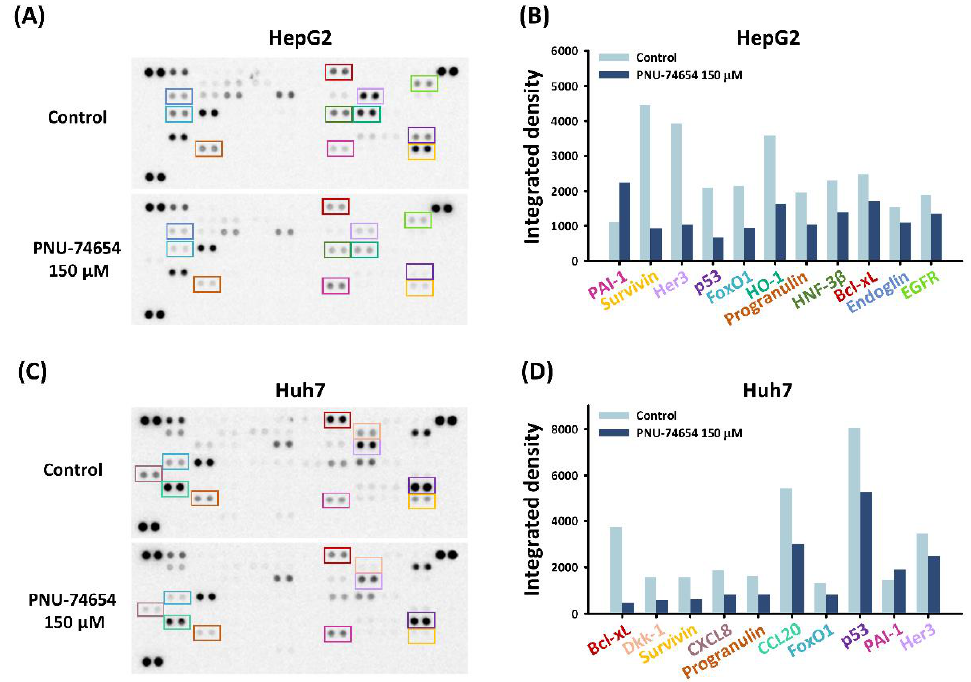
Figure 2. Effects of PNU-74654 on the expression of Bcl-xL and survivin. ( A – D ) An oncology array was conducted to analyze the underlying mechanism of the antineoplastic properties against HCC cells.